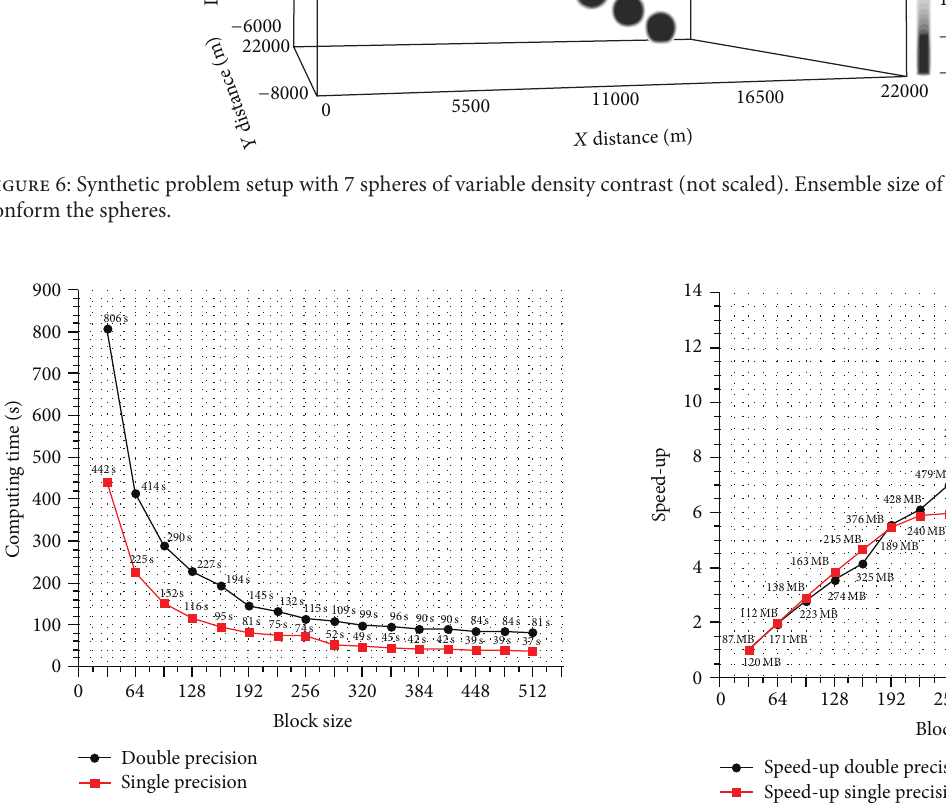
Figure 8: Speed-up of the behavior by increasing the number of threads per block in double and single precision, with its respective quantity of global memory